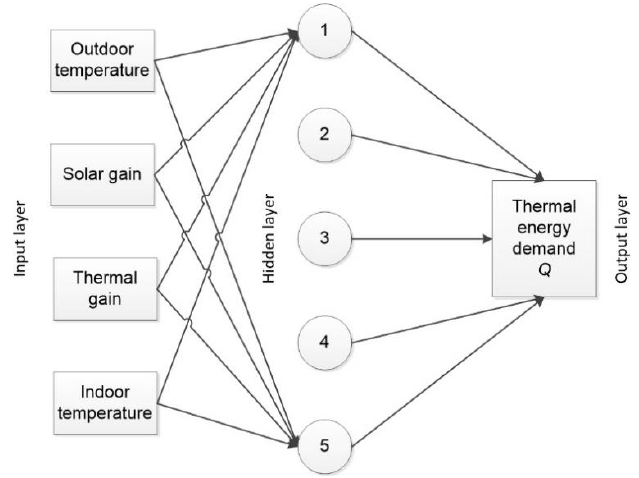
Figure 4. Artificial neural network (ANN) architecture of building prediction model.